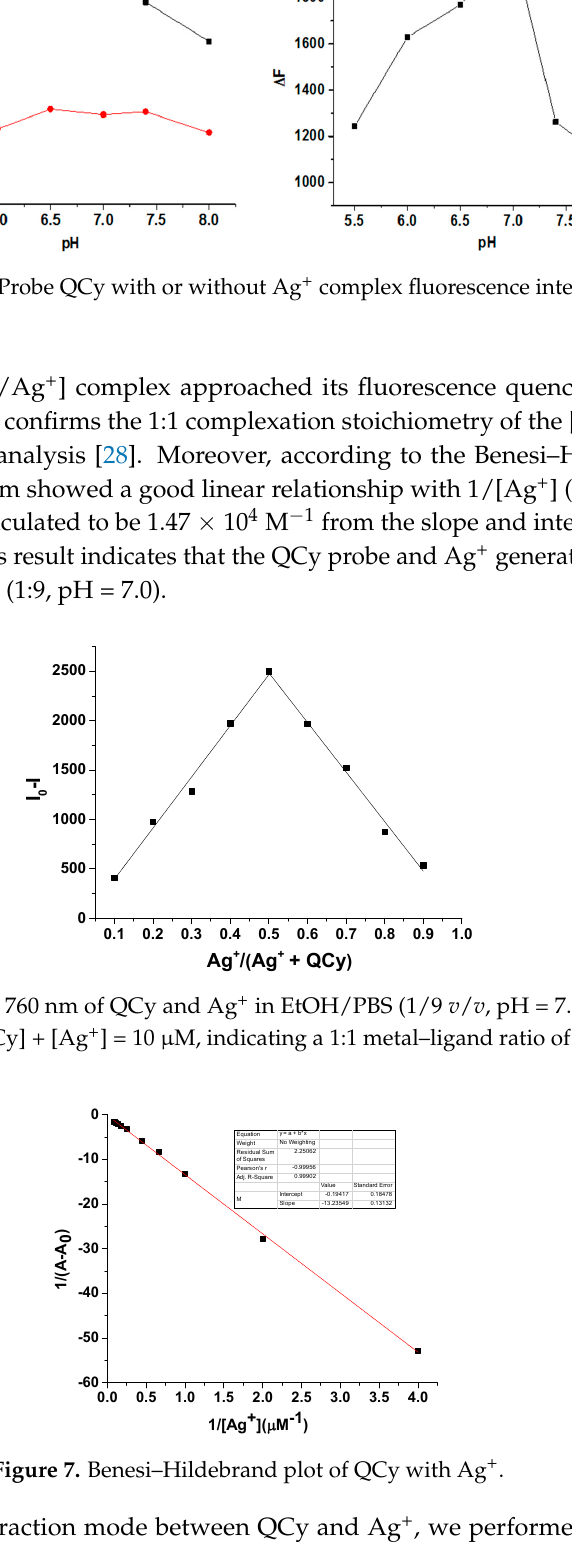
6 of 12 Figure 4. Time ‐ dependent normalized fluorescence changes of QCy (1.0 μ M) with Ag + (5.0 μ M) ( black ) and without ( red ) at 760 nm in EtOH/PBS (1:9 v/v, pH = 7.0, 10 mM). 3.4. The Detection Limit The detection limit was calculated based on fluorescence titration according to the literature [27]. The detection limit of the probe for Ag + was studied using various concentrations of Ag + (0.0 – 7.0 μ M). The fluorescence intensity at 760 nm was plotted as a function of Ag + concentration in EtOH/PBS (1/9, v/v, pH = 7.0, 10 mM). We also measured the fluorescence emission spectra of QCy 11 times at each Ag + concentration, to obtain the standard deviation of the blank measurement. To obtain the slope, the fluorescence intensity at 760 nm was plotted against the concentration of Ag + . Thereafter, the detection limit was calculated, using the following equation: